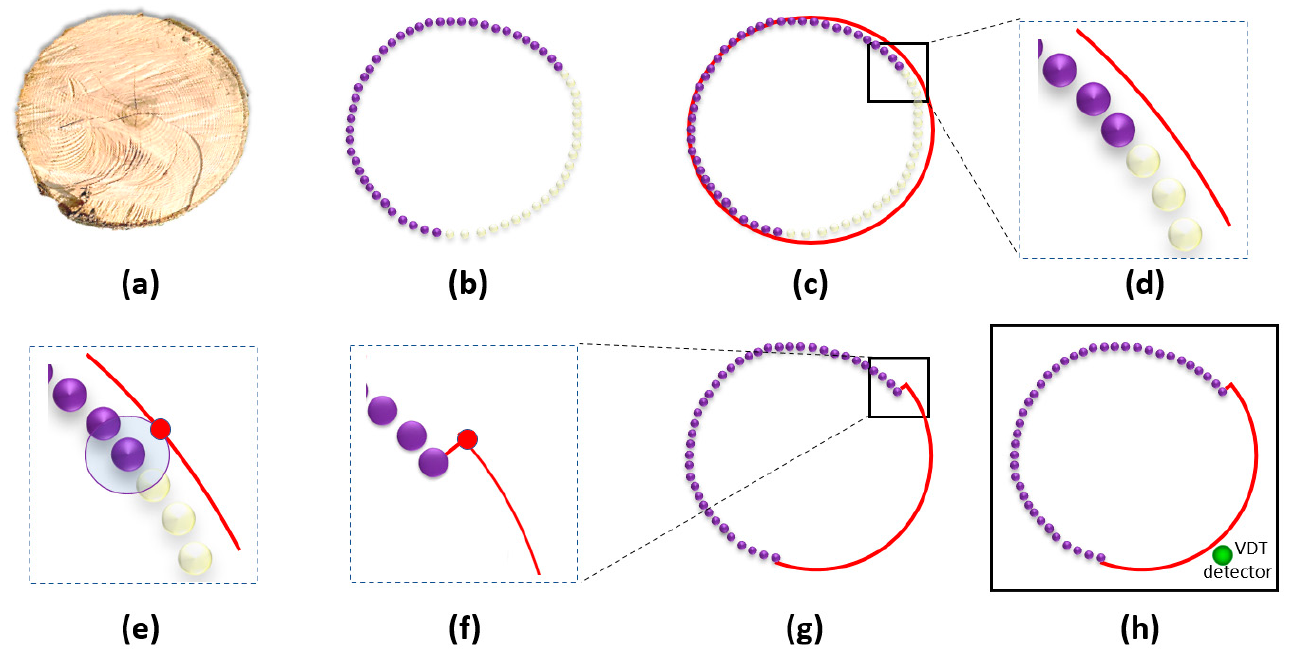
Figure 3. The workflow of the amelioration process: ( a ) a stem disk; ( b ) the demonstration of the recorded points (in purple) and the missing points (in white); ( c ) the fitted circle (in red); ( d ) partial enlargement of the boundary area between the recorded and missing points; ( e ) using of buffer to generate the breakpoint, the red color point; ( f ) enclosing the area between the recorded (purple) point and the breakpoint; ( g ) finishing the synthetic ideal point cloud; ( h ) applying VDT method, the VDT detector is in green; photo of stem disk: Freeimages.com/Artur Ł uczka.